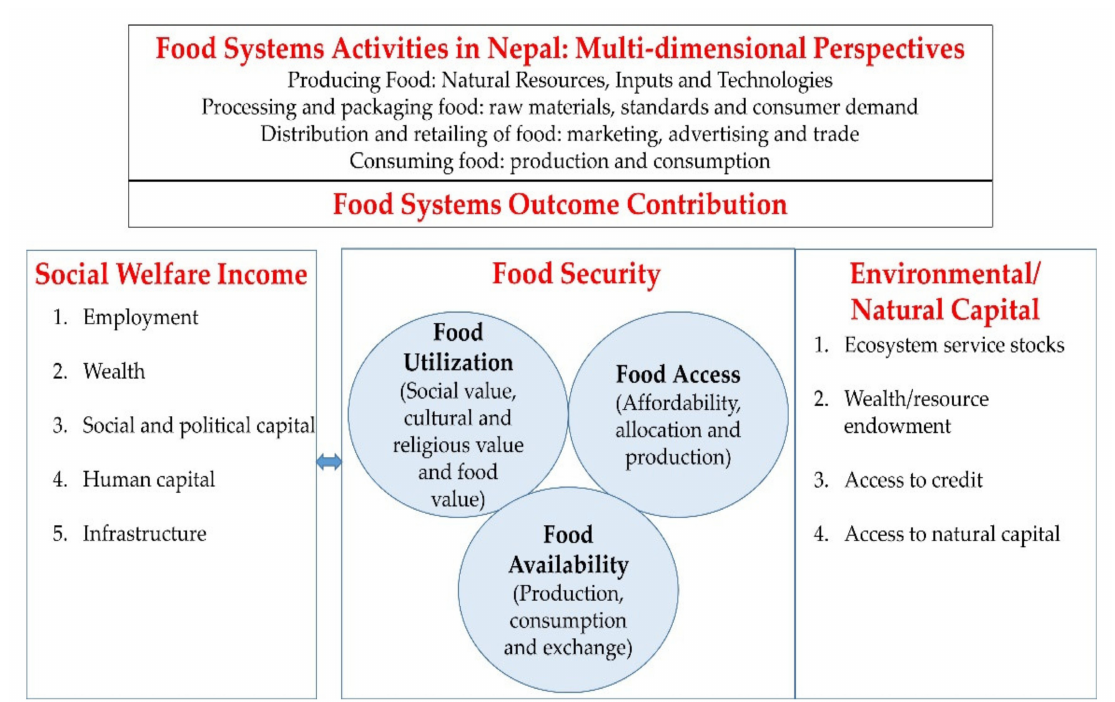
Figure 4. A modified nexus framework of food system in Nepal (adopted from Ericksen [12] as reported by Immaculate